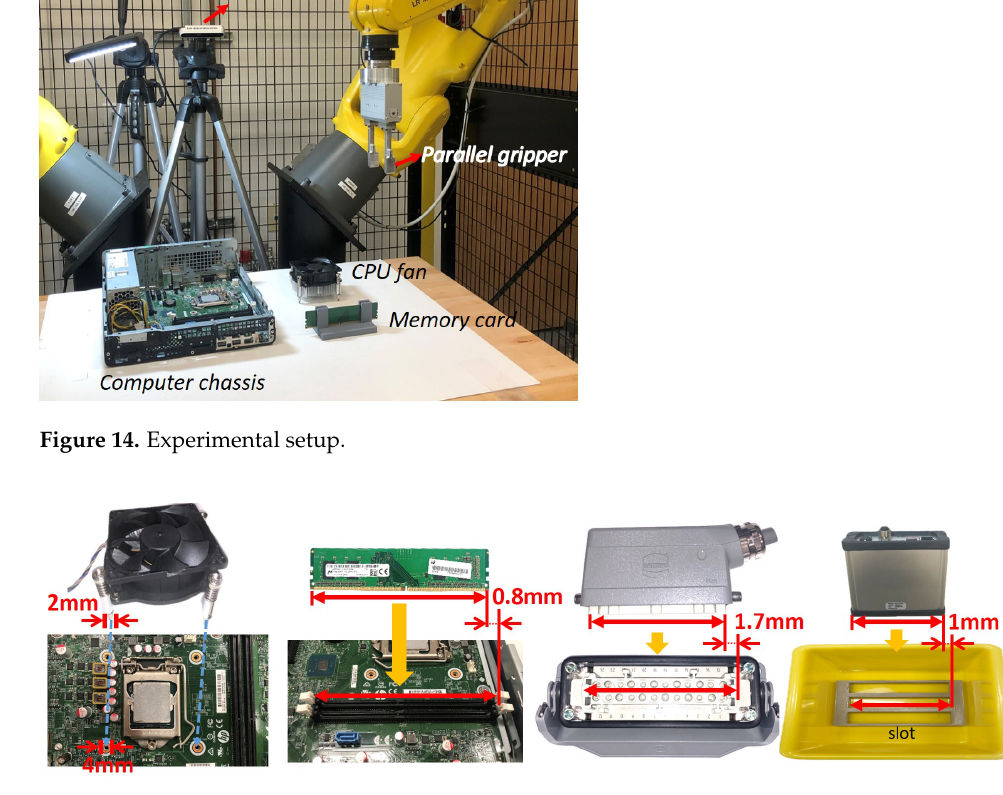
Figure 15. The installation clearances of each